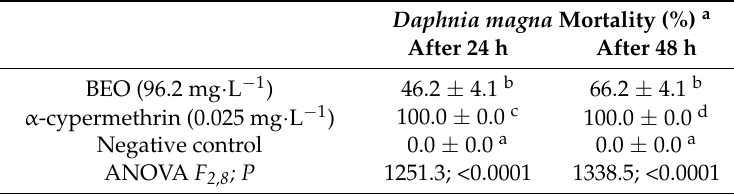
Table 3. Acute toxicity of Peumus boldus leaf essential oil and α -cypermethrin against Daphnia magna adults. All compounds were tested at the LC 90 calculated on Culex quinquefasciatus 3rd instar larvae.